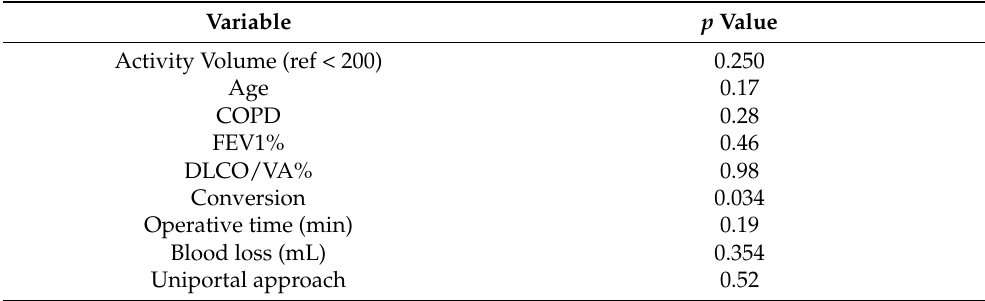
Table 7. Univariable linear regressions of variables possibly associated with a longer length of hospital stay.